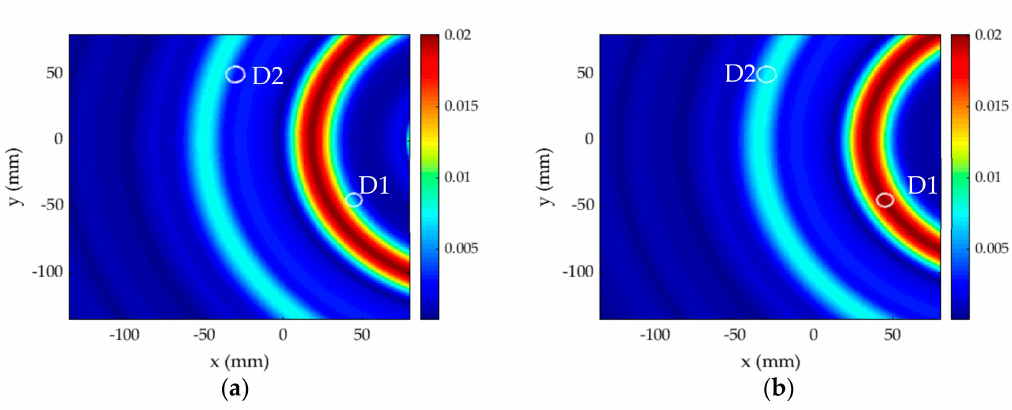
Figure 21. Baseline-free damage possibilities in multiple damage scenario for sensing path A8B8: ( a ) without time compensation; ( b ) with time compensation.